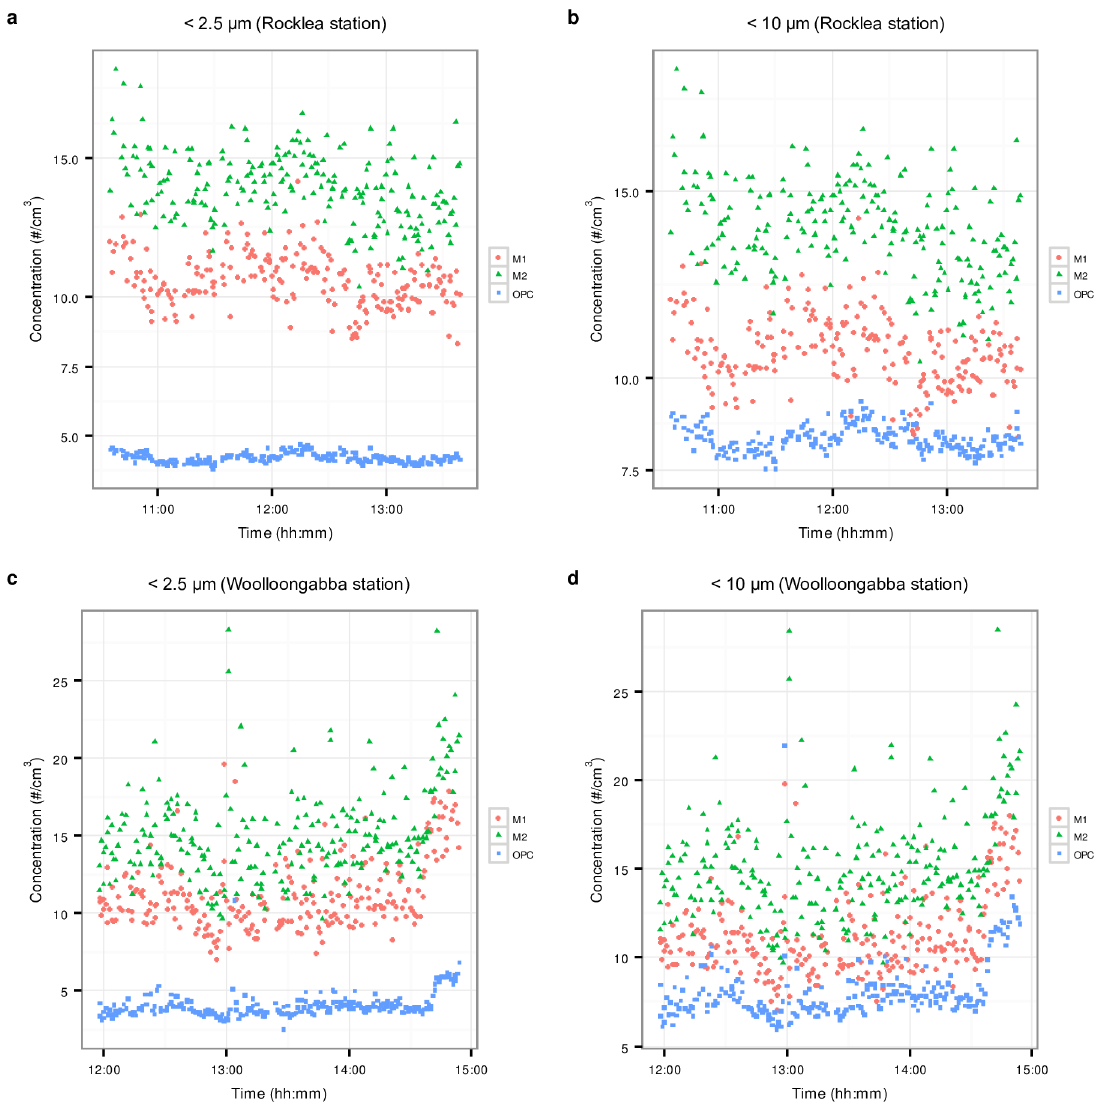
Fig 4. Time series of ambient particles number concentrations. a) Rocklea station, particles in the size range: M1 (cid:20) 2.5 μ m, M2 (cid:20) 2.5 μ m and OPC (cid:20) 2.1 μ m. b) Rocklea station, particles in the size range: M1 (cid:20) 10 μ m, M2 (cid:20) 10 μ m and OPC (cid:20) 7 μ m. c) Woolloongabba station, particles in the size range: M1 (cid:20) 2.5 μm, M2 (cid:20) 2.5 μm and OPC (cid:20) 2.1 μm. d) Woolloongabba station, particles in the size range: M1 (cid:20) 10 μm, M2 (cid:20) 10 μm and OPC (cid:20) 7 μm.